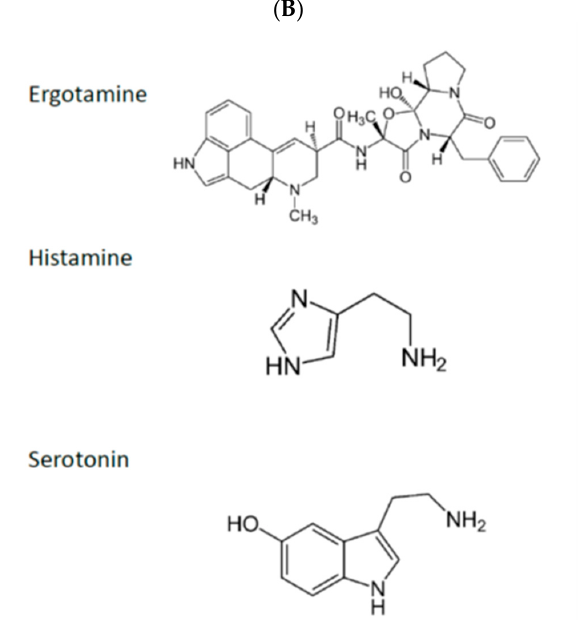
Figure 1. ( A ) Signal transduction: Serotonin activates and tropisetron antagonizes 5-HT4-receptors in the sarcolemma. Histamine activates and cimetidine antagonizes H2-receptors in the sarcolemma. Ergotamine can activate both receptors. Activation of these receptors lead via GTP binding stimula- tory protein (Gs) an increased activity of adenylyl cyclases (AC). Thereby, more cAMP is generated. The formed cAMP is finally degraded by phosphodiesterases (PDE). The cAMP can activate cAMP- dependent kinases (PKA) that phosphorylate and activate target proteins in the heart. These included the L-type Ca channel (LTCC) that facilitates the entry of “trigger” Ca ion into the cell. Here, Ca ions can bind to myofilaments. Phosphorylation of the troponin inhibitor (TnI) or phospholamban (PLB) hasten cardiac relaxation. For instance, phosphorylation of PLB allows SERCA to pump more Ca ions from the cytosol into the sarcoplasmic reticulum. In the sarcoplasmic reticulum, Ca ions bind to calsequestrin (CSQ). The ryanodine receptor upon phosphorylation will allow more Ca ions to leave the sarcoplasmic reticulum and enter the cytosol. ( B ) Structural similarities: There are structural similarities between serotonin and ergotamine or histamine and ergotamine. Compare the azole ring in ergotamine to the imidazole ring in histamine. Compare the indole ring in ergotamine with the indole ring in serotonin. This may explain the activation of both receptors in ( A ) by ergotamine. In humans, H 2 -histamine receptors are present in both the atrium and ventricle